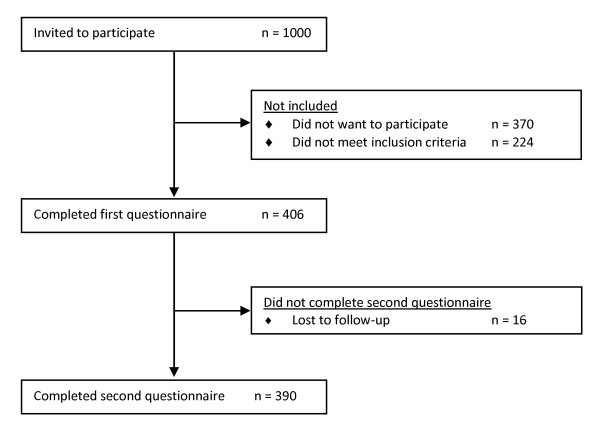
Flowchart of participants in the study of inconvenience due to travelers' diarrhea.